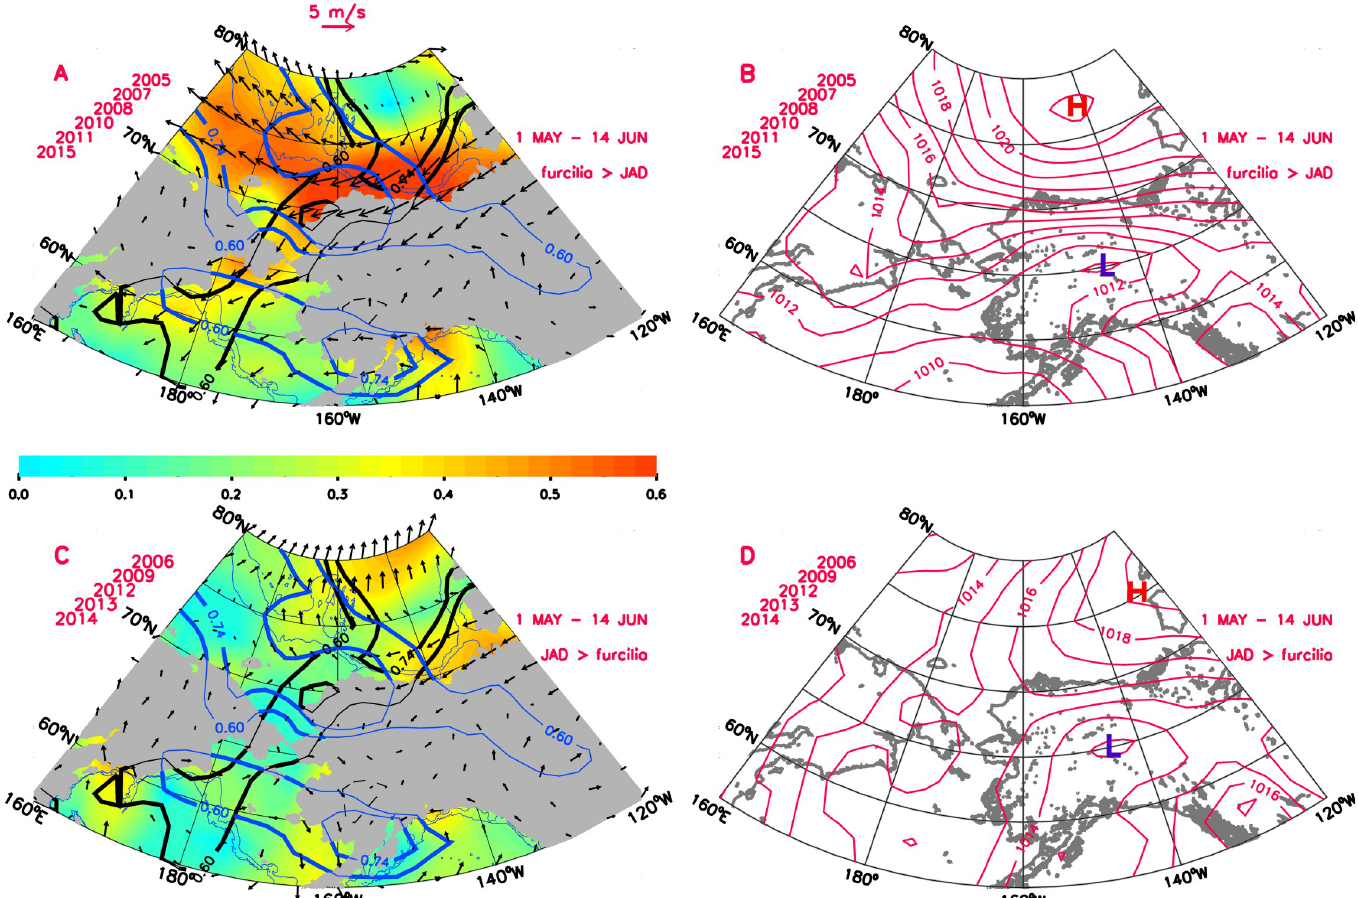
Fig 8. Mean atmospheric circulation from 1 May to 14 June for years in which furcilia fractions are greater (A, B) or lesser (C, D) than JAD fractions. A) and C) display mean wind vectors (at every 2nd ith grid point), wind directional constancy (color shading) and statistically-significant correlations between JAD fraction and U- component winds (blue contours) and V-component winds (black contours) with correlation contours at r = 0.60 (p < 0.05) and 0.74 (p < 0.01). B) and D) display mean sea level pressure (hPa) patterns. High and low pressure cells are annotated with H and L, respectively. Maps generated using IDL (Interactive Data Language)/v8.6.